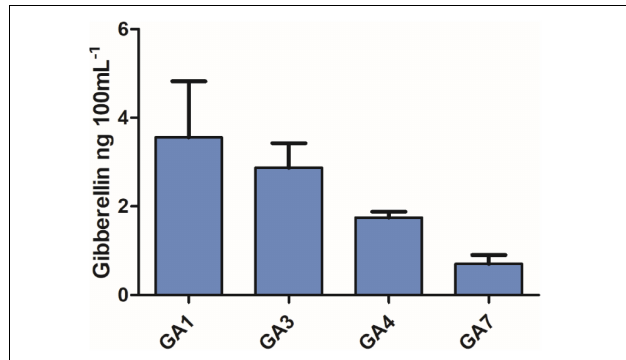
FIGURE 1 | Quantification of gibberellin content in the Curvularia lunata (AR11) pure